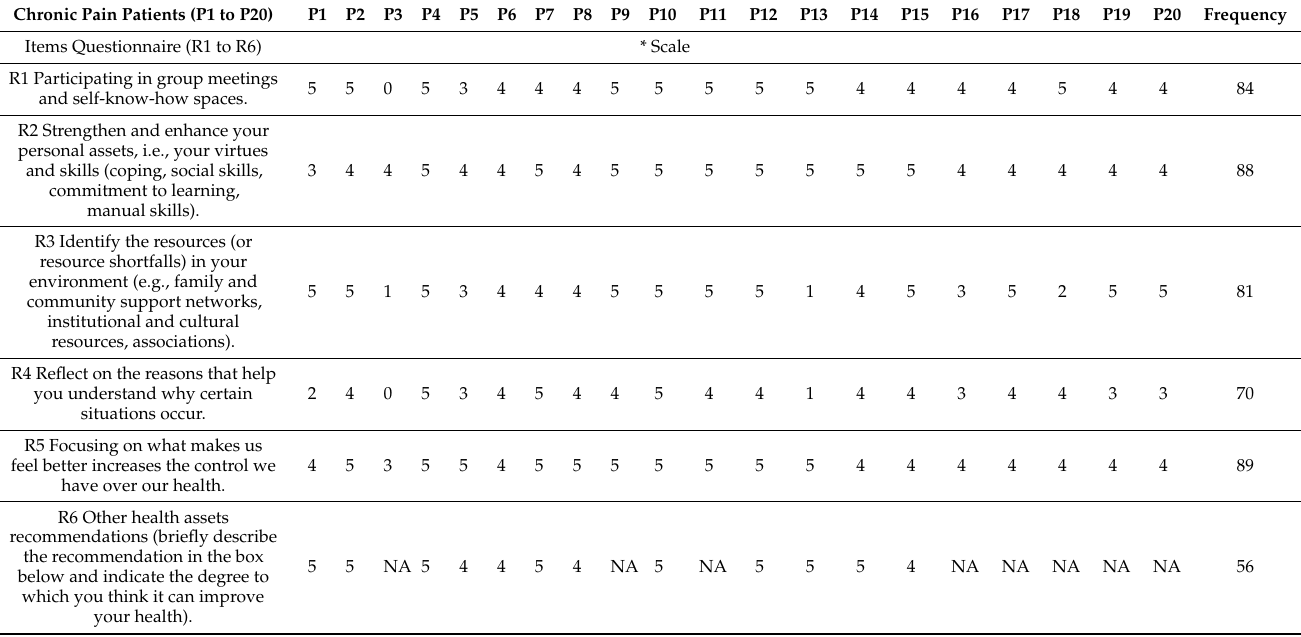
Table 5. Degree to which health assets recommendations can improve health.